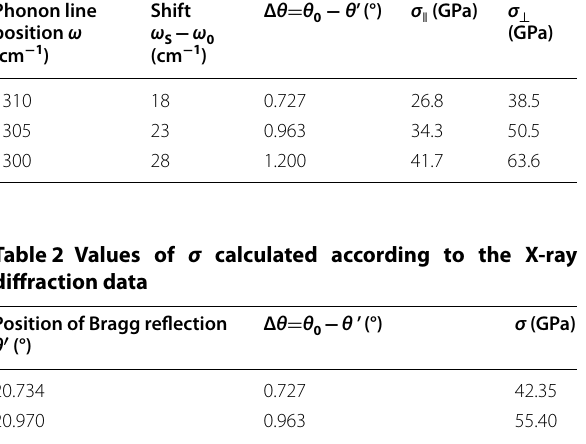
Table 1 Values of σ spectroscopy and X-ray diffraction data Phonon line position ω